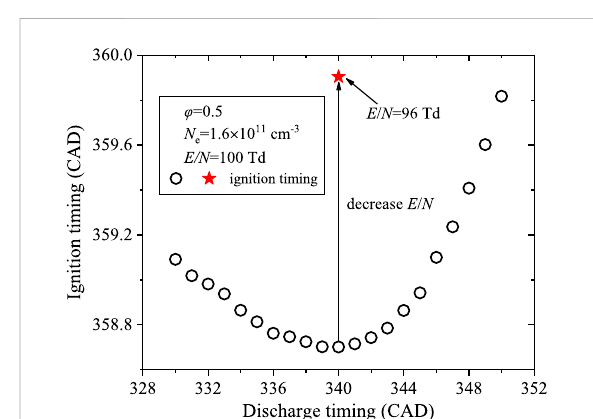
FIGURE 15 Ignition timing as a function of φ .